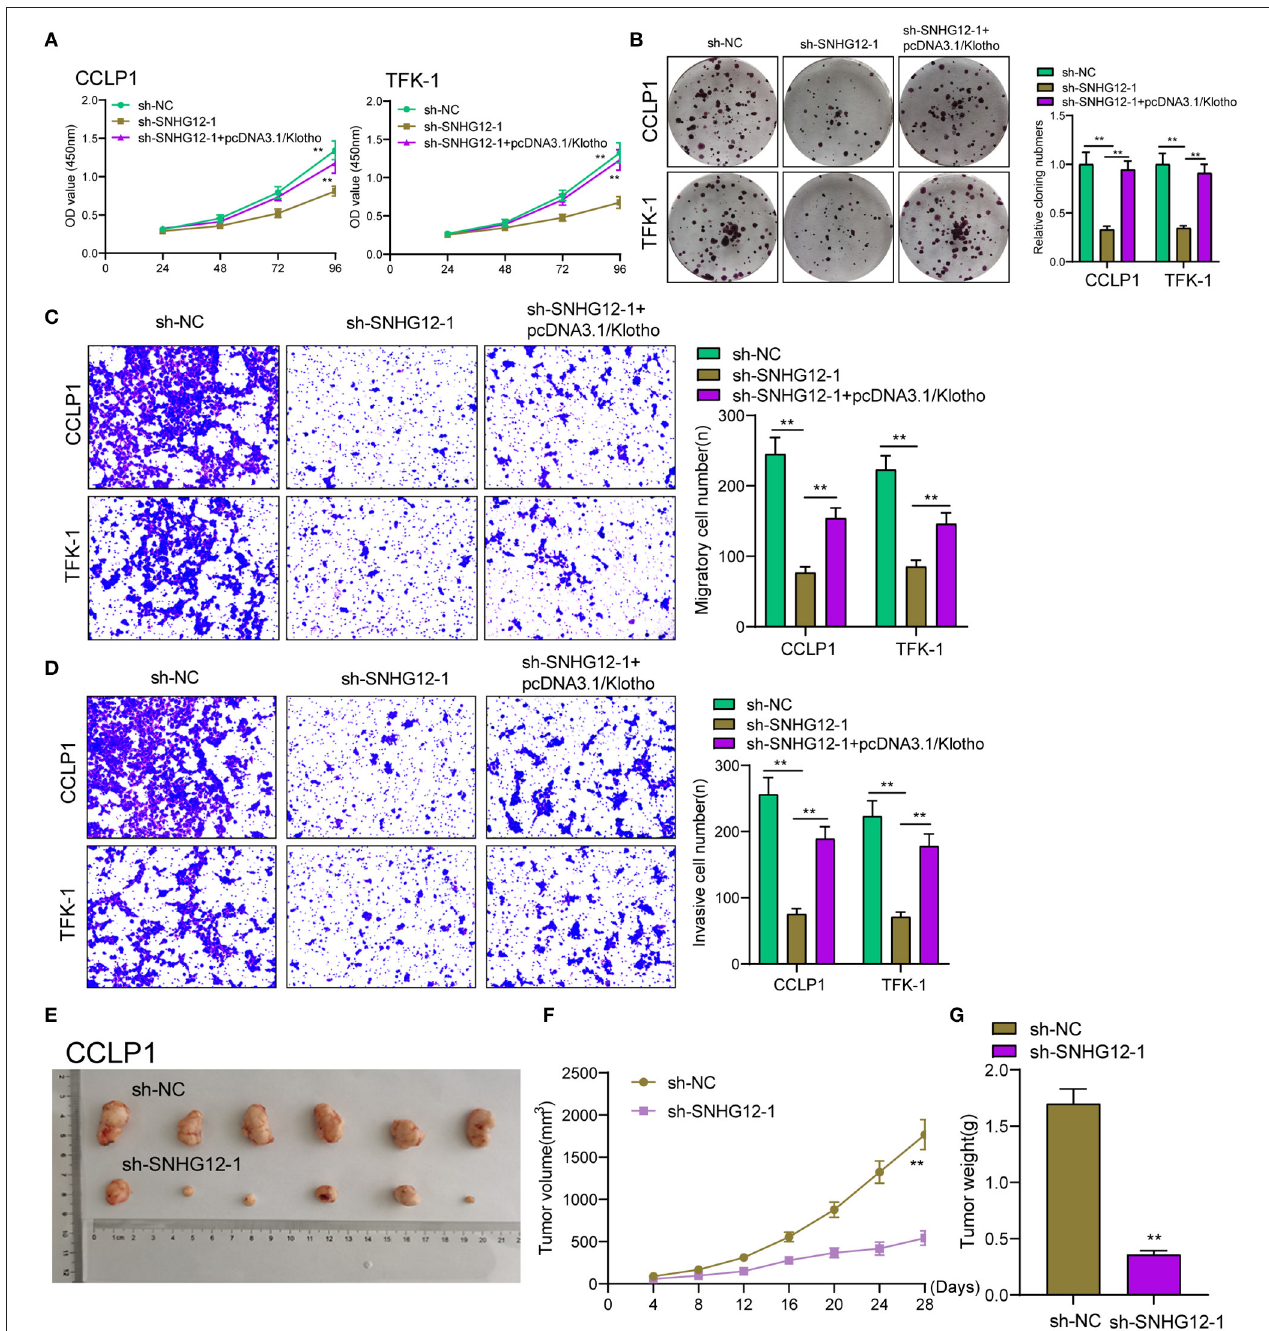
FIGURE 6 | The upregulation of Klotho reversed functional depletion caused by SNHG12 knockdown. (A) CCK-8 assays were applied to determine the proliferation of TFK-1 and CCLP1 cells cotransfected with sh-NC, sh-SNHG12-1 or sh-SNHG12-1 + pcDNA3.1/Klotho. (B) Colony formation assays were used to detect the proliferation of TFK-1 and CCLP1 cells cotransfected with sh-NC, sh-SNHG12-1 or sh-SNHG12-1 + pcDNA3.1/Klotho. (C–E) Transwell assays were applied to determine the migration and invasion of TFK-1 and CCLP1 cells cotransfected with sh-NC, sh-SNHG12-1 or sh-SNHG12-1 + pcDNA3.1/Klotho. (E) Tumors derived from mice in two different groups were presented. (F,G) Tumor volume and weight in the xenograft mice from the SNHG12-knockdown group and the control group. ** p < 0.01.